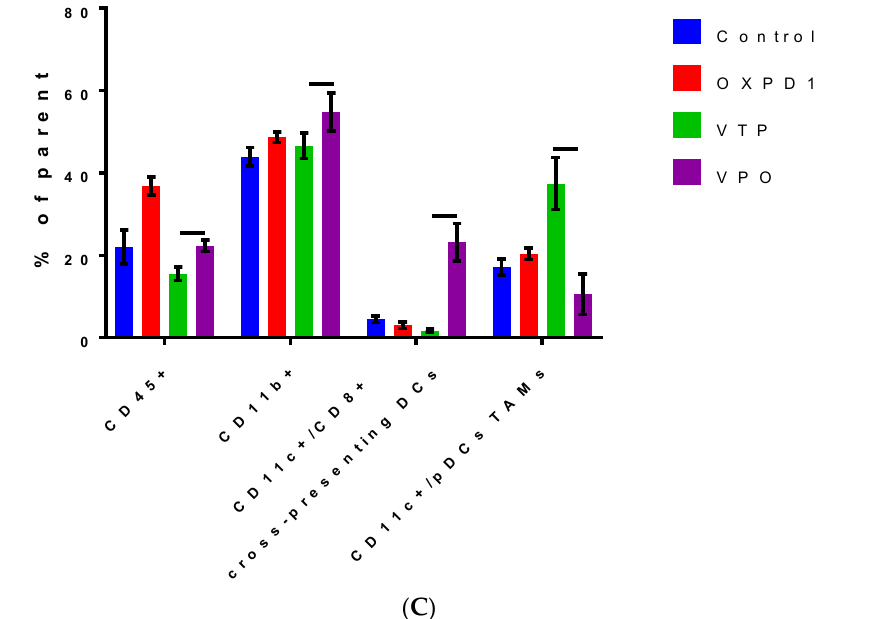
Figure 4. Combined PD-1 inhibitor/OX40 agonist therapy alters the frequency of specific myeloid cell subsets in VTP-treated tumors by day 7 post-treatment. ( A ) Representative flow cytometry plots identifying myeloid cell subsets within viable single cells. ( B ) Heat map summarizing the findings of flow cytometry analyses of tumor samples at day 7 after treatment. Values in boxes represent the mean percentage of each cell subpopulation (highlighted by row) in each experimental condition (highlighted by column). ( C ) Plot of flow cytometry data shown as the percentage of positive events among parent gated events. DCs, dendritic cells; pDCs, plasmacytoid dendritic cells; Conv DCs, conventional dendritic cells; TAMs, tumor-associated macrophages; MDSCs, myeloid-derived suppressor cells. Graph bars indicate mean ± SEM. * p < 0.01. OXPD1, OX40 agonist plus PD-1 inhibitor; VTP+OX40+PD-1, VTP plus PD-1 inhibitor and OX40 agonist.